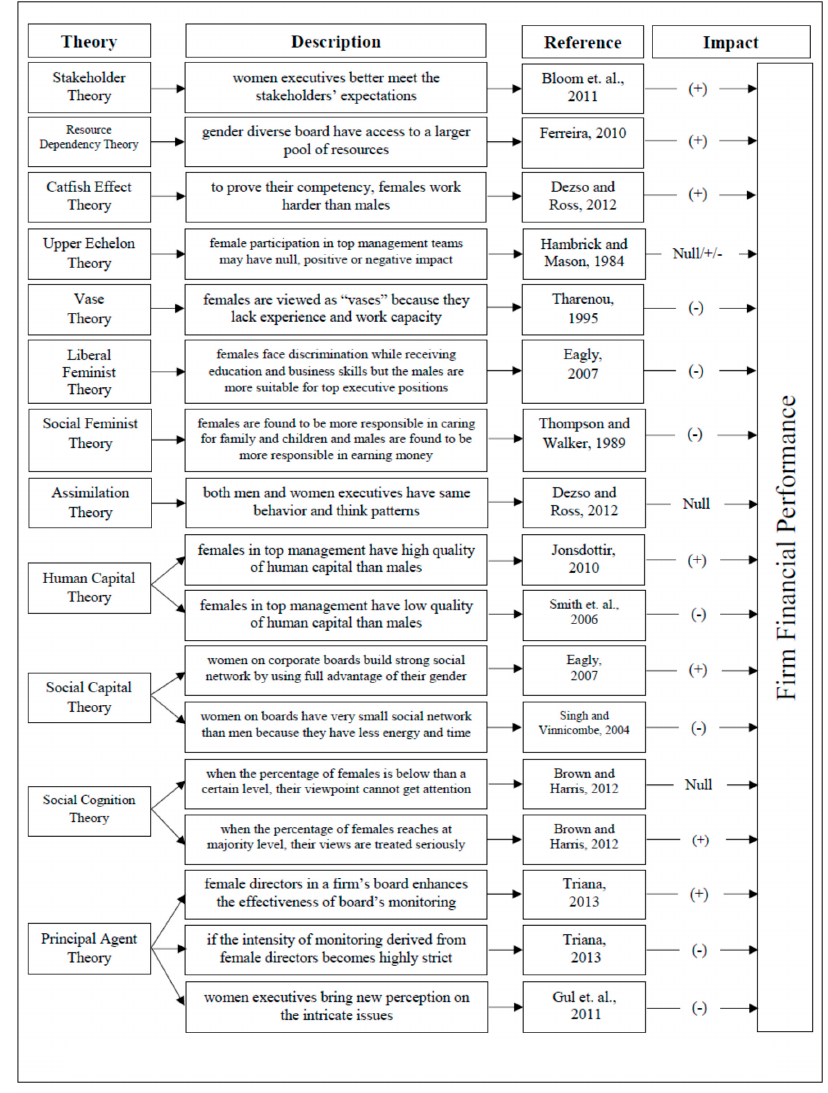
Figure A1. Firm performance: conceptual model based on multi-approach perspective.